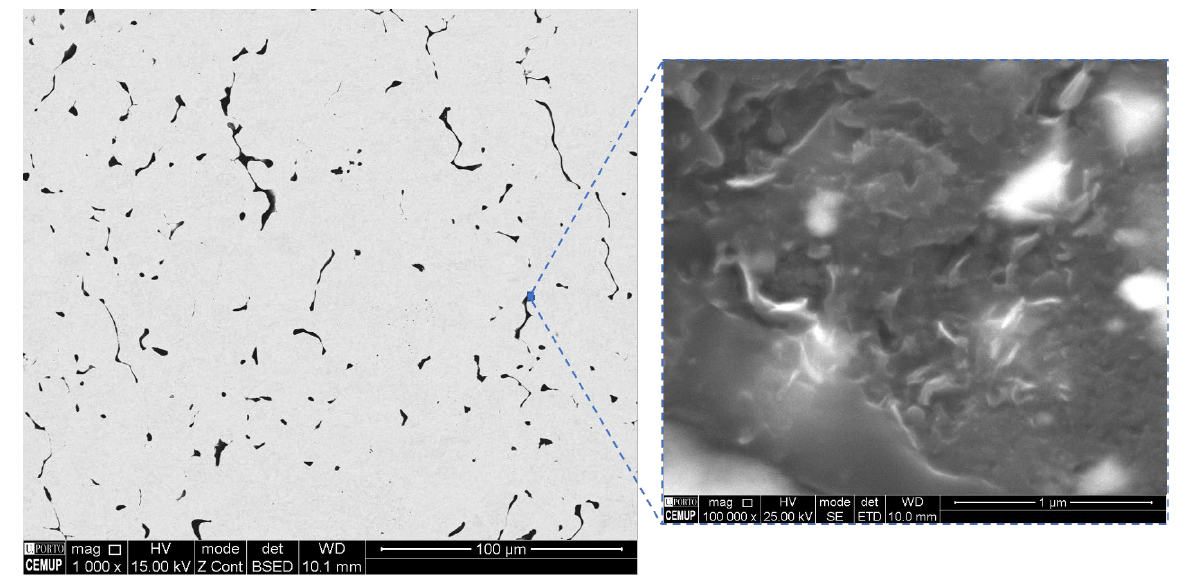
Figure 11. SEM images of Ni-CNT nanocomposite as-sintered and heat-treated at 1100 °C for 30 min showing high magnification images with the CNTs damage.